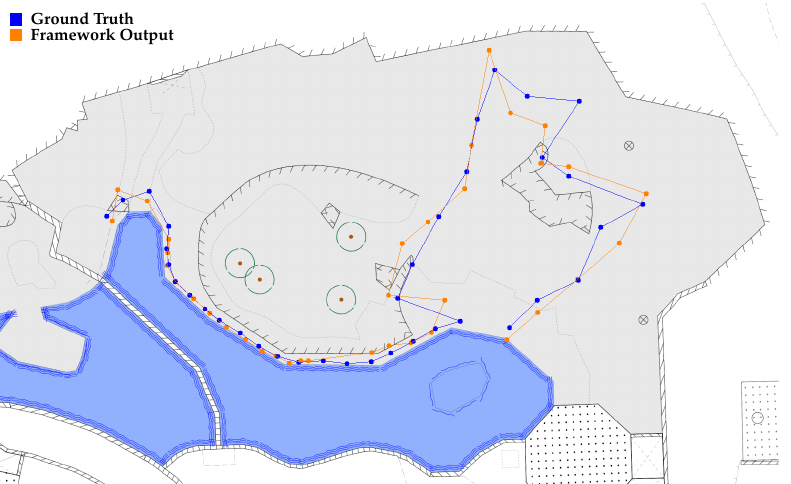
Figure 5. Graphical representation of the result of experiment 6. A person followed a trajectory while being tracked by the proposed framework. The output of the framework is shown in orange. At the same time, the person was positioned by two laser-based distance measuring devices. This trajectory, assumed to be ground truth, is depicted in